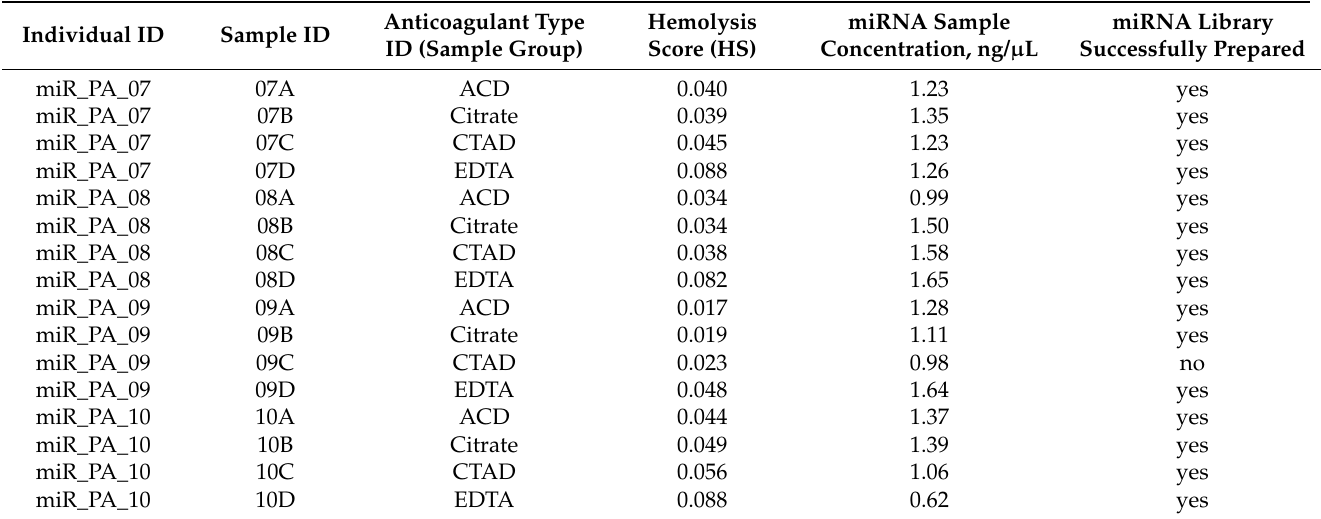
Table A1. Characteristics of biological samples.